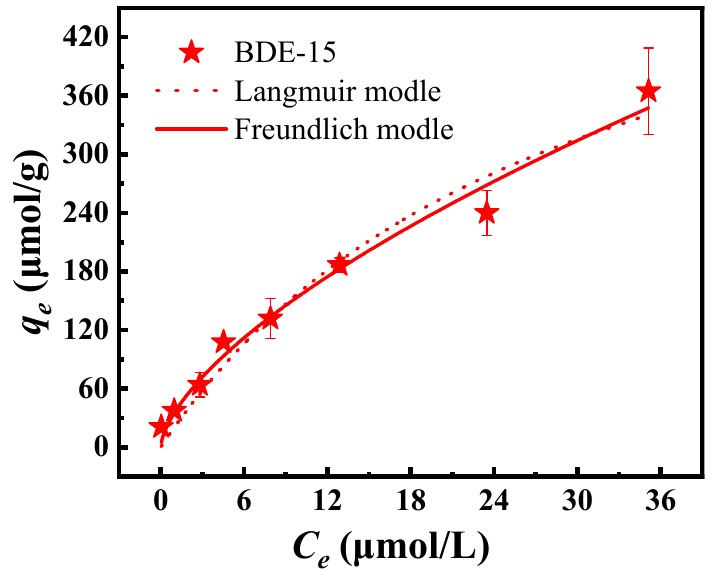
Figure 3. Fitting curves of isothermal adsorption of BDE-15 by GAC (Adsorption conditions: T = 298 K; C TX-100 = 1 g/L; pH = 6; Dosage = 0.1 g/L).